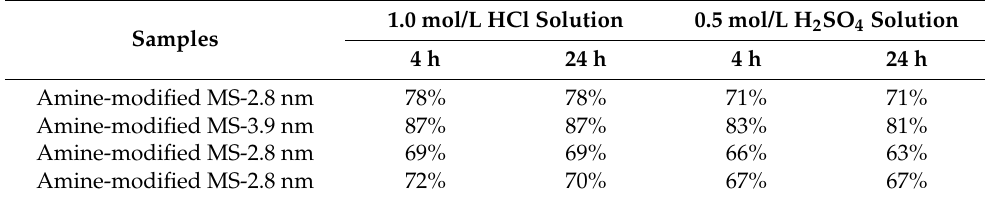
Table 4. Recovered percentage of Zn, %R, using acid solutions. Samples